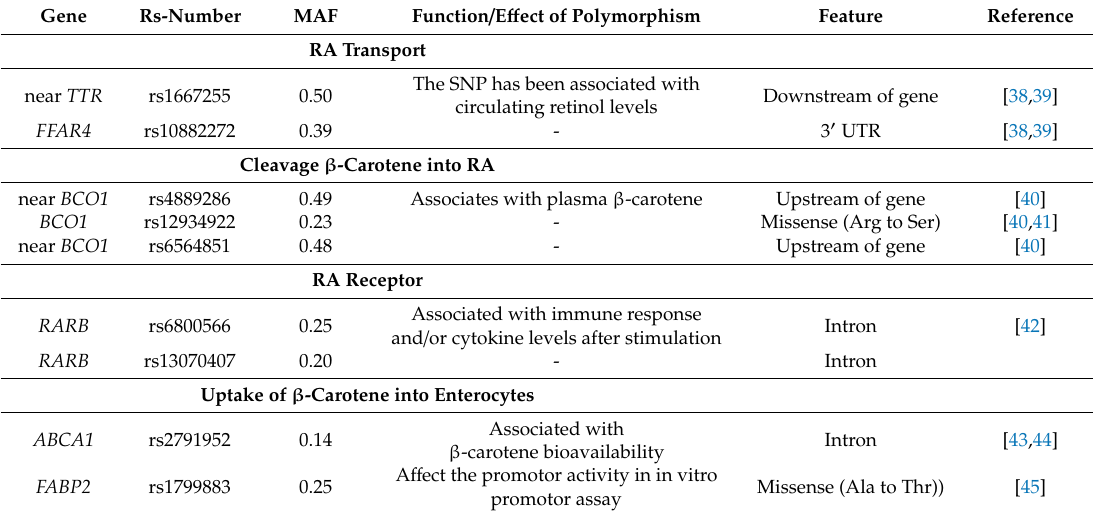
Table 2. Suggested biological e ff ects of the selected polymorphisms.